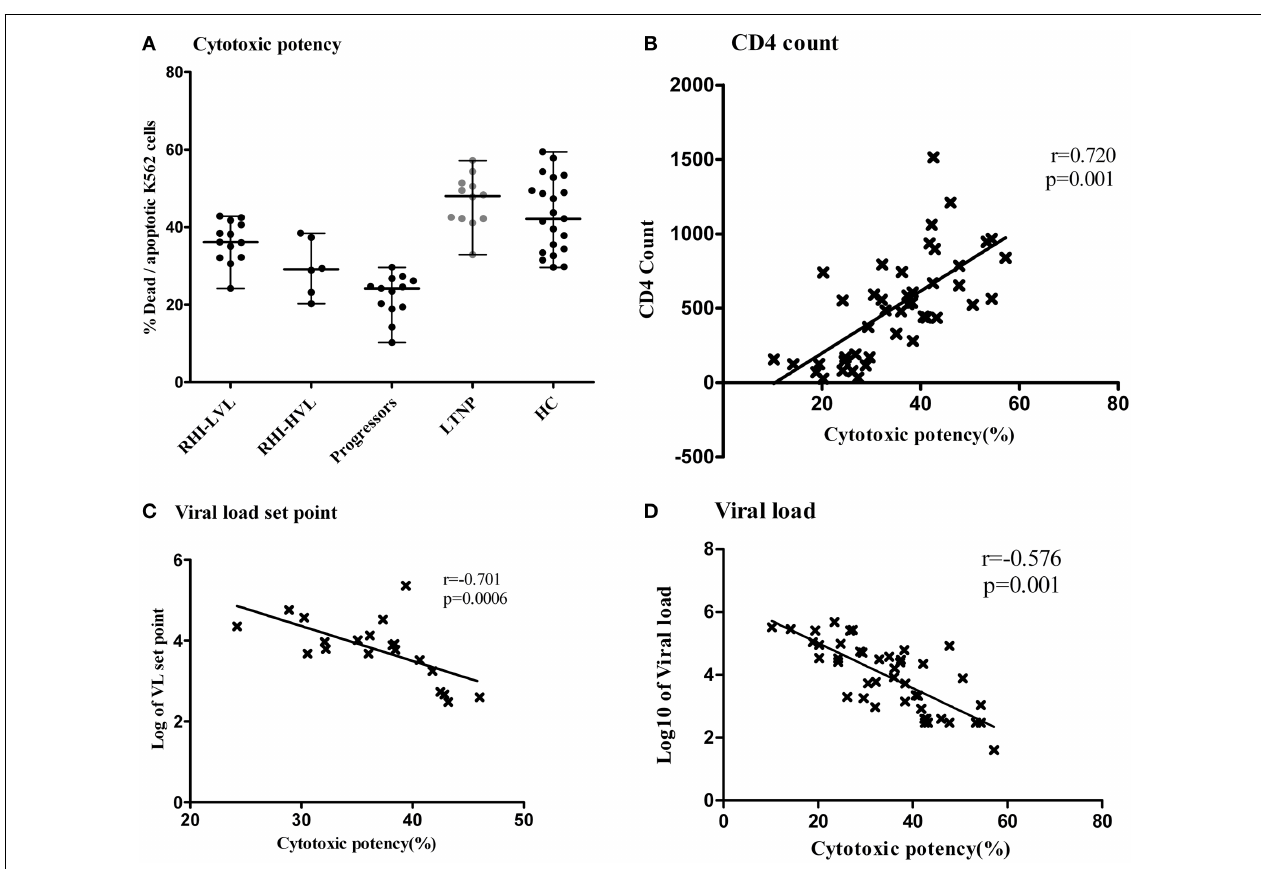
color) (A) . Association of cytotoxic potency of NK cells ( X axis) with the markers of disease progression on y axis; the CD4 count (B) and the plasma viral load set point (C) and viral load at enrollment visit in HIV-1 infected study participants (D)